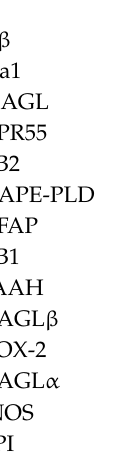
Figure S5: One whole membrane was used for Iba1 and α -adaptin immunoblotting on 5xFAD mice hippocampus (unedited blots, Figure